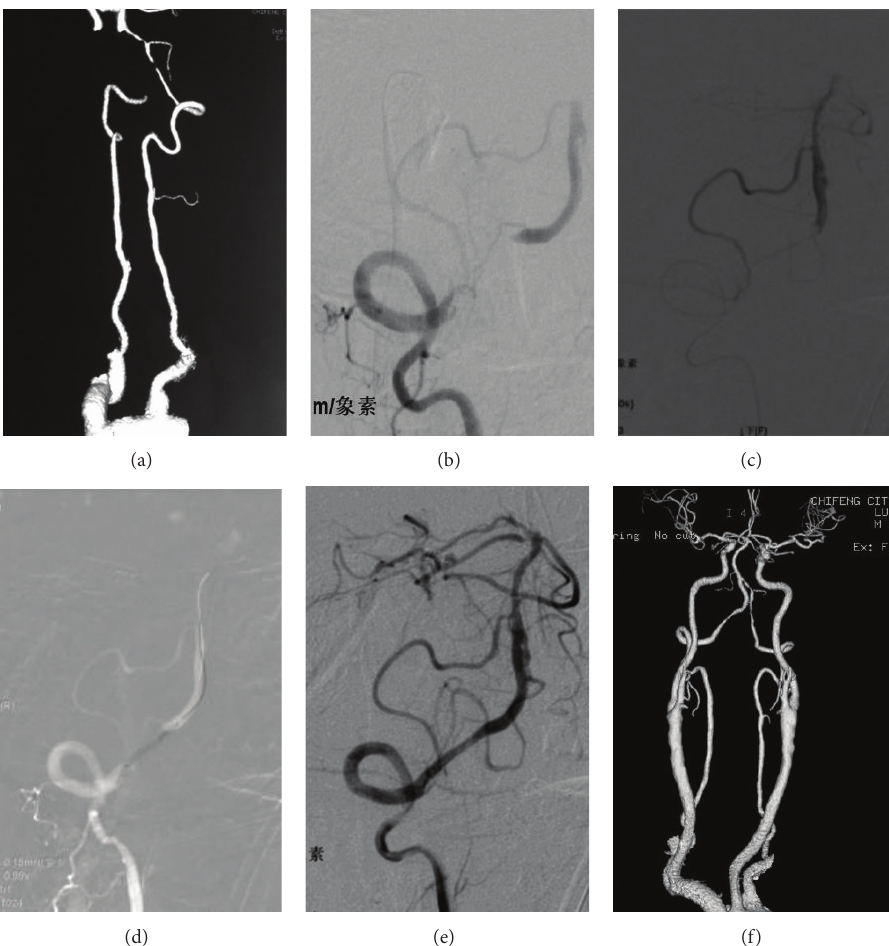
Figure 2: A 72-year-old man (case 6) with right intracranial vertebral artery (ICVA) total occlusion and contralateral severe stenosis confirmed by CTA (a) and DSA (b). The distal patency was confirmed by angiography through microcatheter (c). The lesion was predilated with a 2 × 20 mm Invatec balloon (d) and covered with a 3 × 19mm Invatec balloon-expandable stent (e). A 24-month follow-up CTA showed mild in-stent stenosis